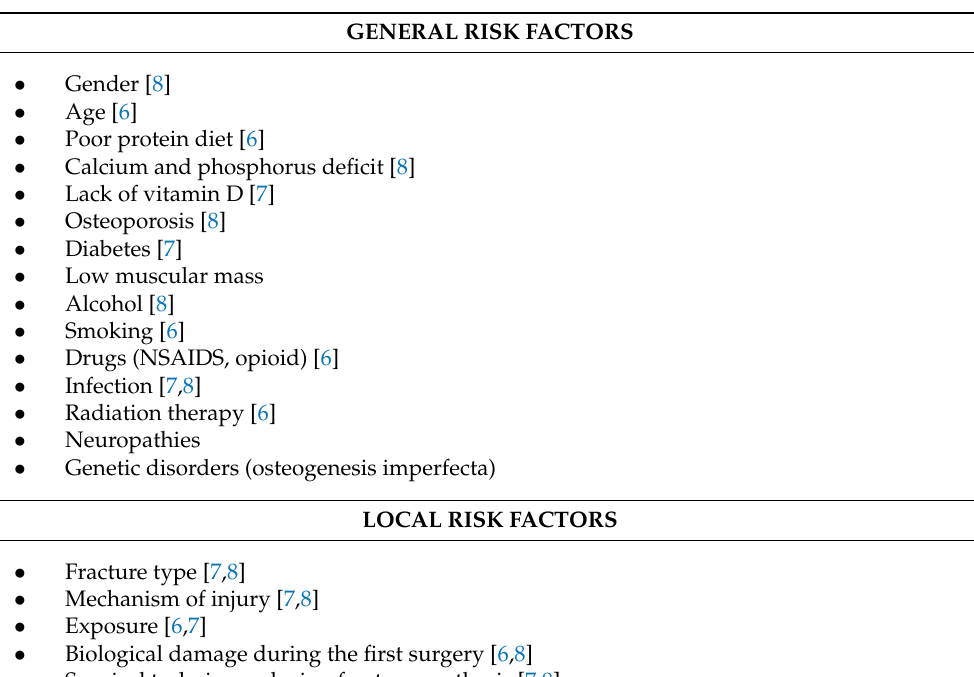
Table 2. General and local risk